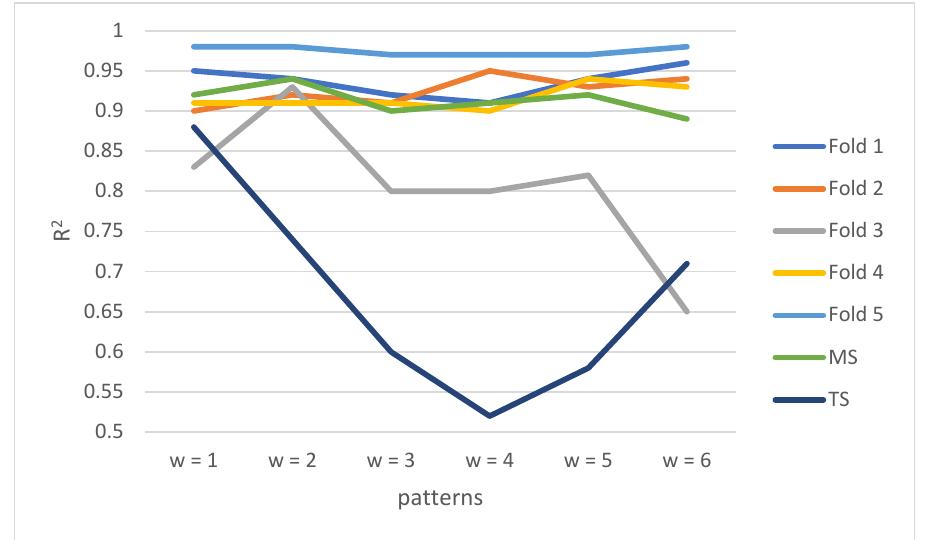
Figure 6. Metrics comparison in the validation set and the test set for RF.